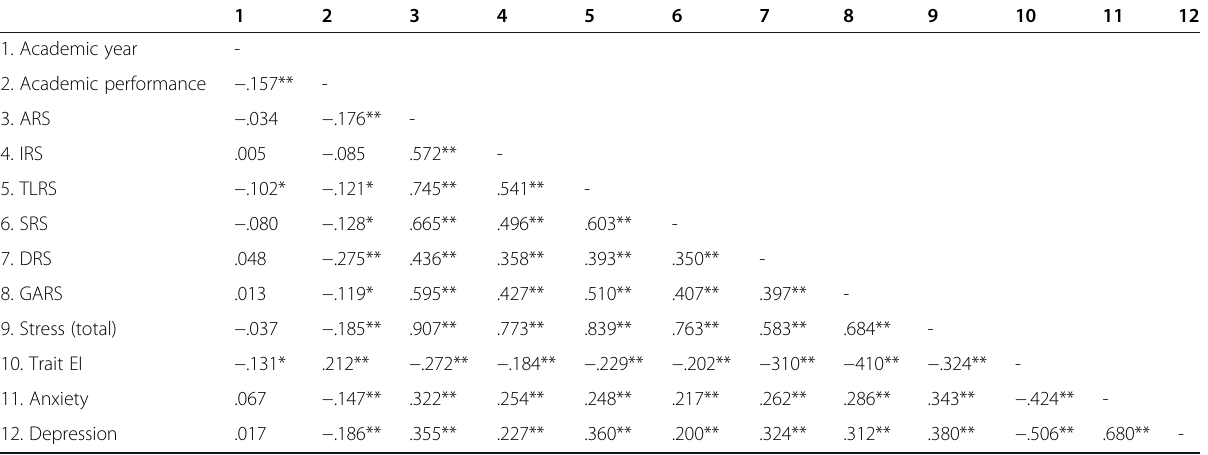
Table 4 Correlation between stress domains, trait EI, anxiety and depression